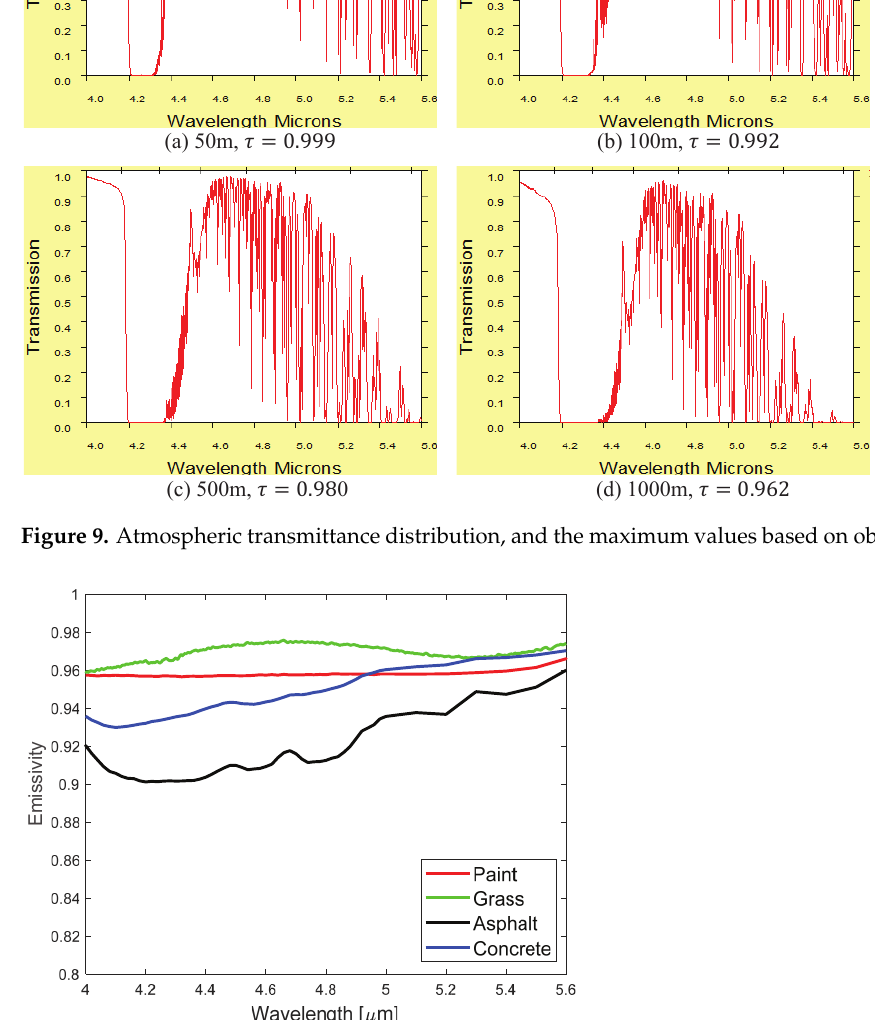
Figure 10. Emissivity distributions of various materials in the upper MWIR